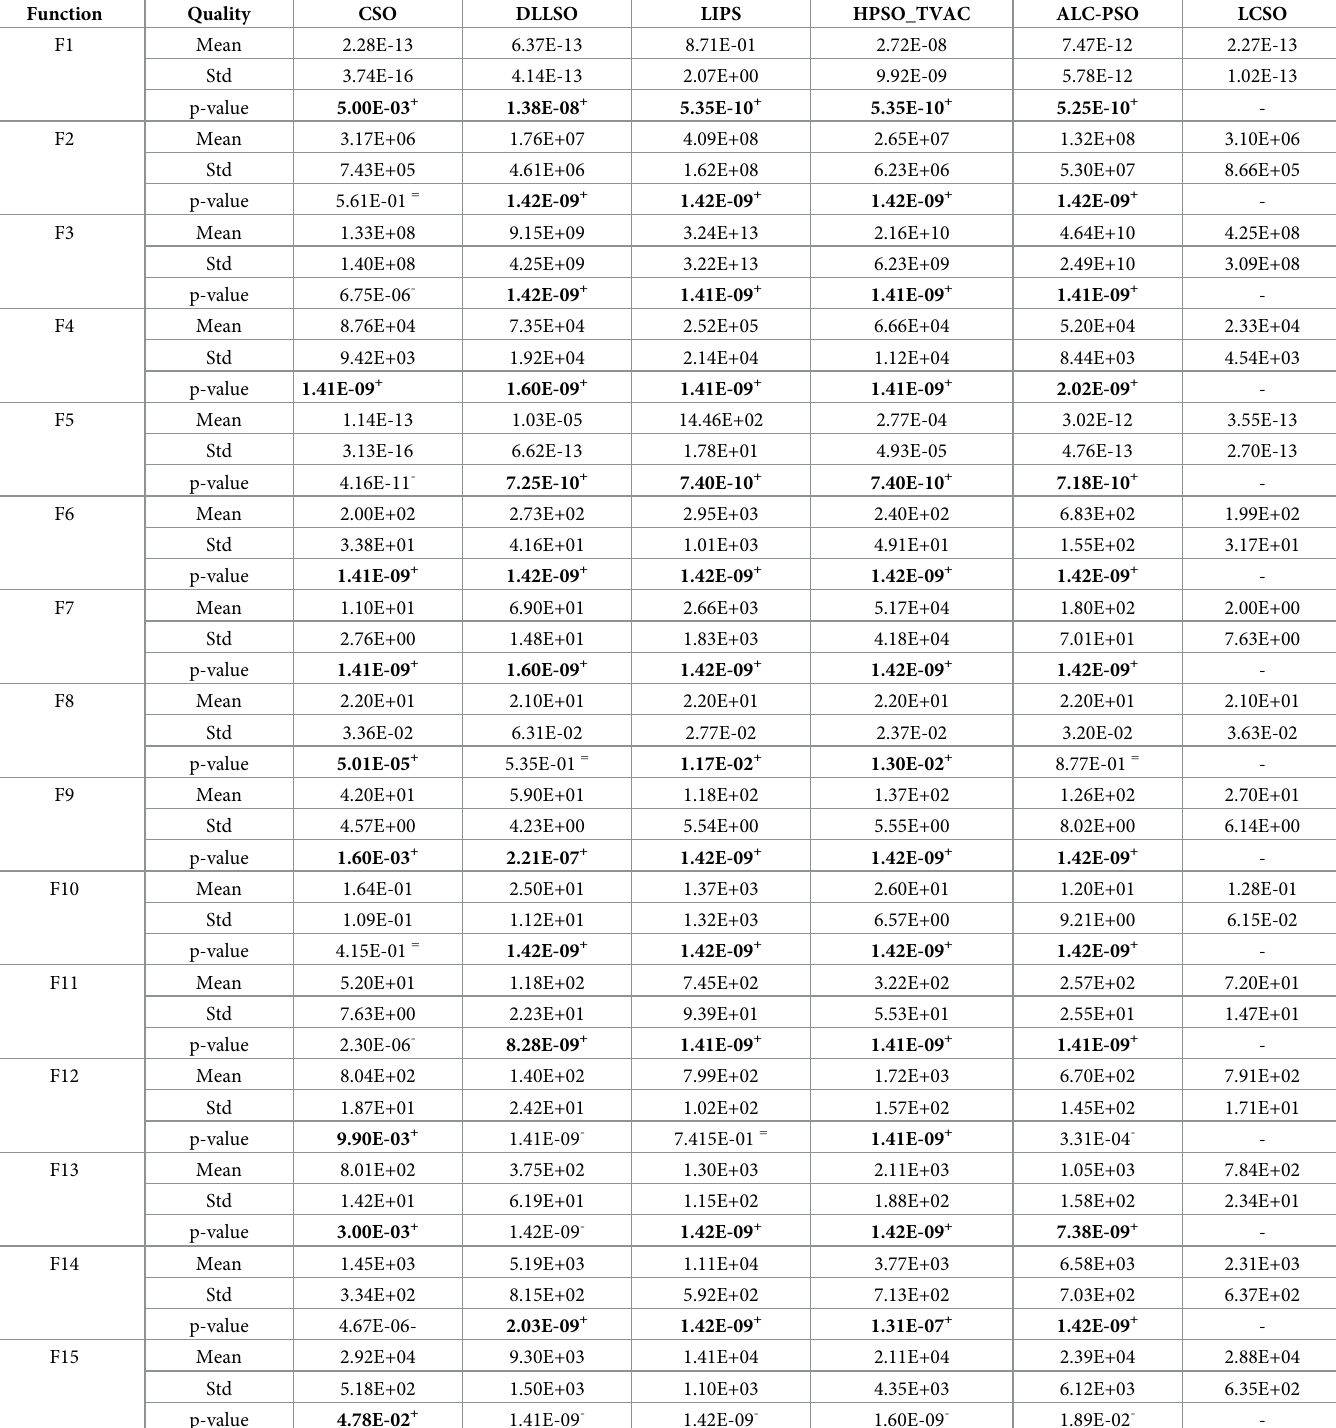
Table 2. Comparison results of the compared algorithms on CEC’2013 functions with 6 × 105 fitness evaluations.